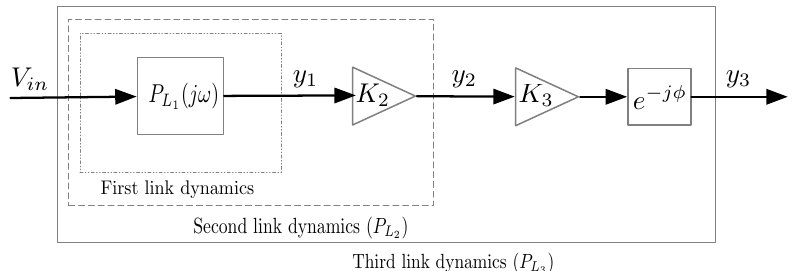
Figure 8. Diagram block of swimming robot model for single